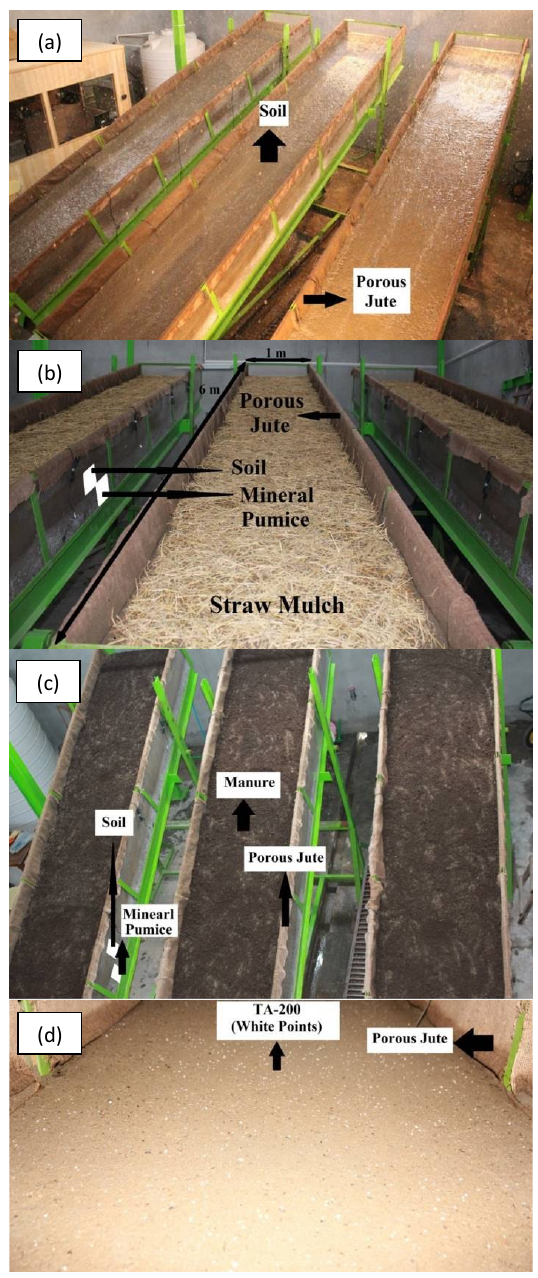
Fig. 1 A view of untreated plots (a), treated plots with rice straw mulch (b), manure (c) and TA-200 polyacrylamide (d) under the lab condition Figure 1. A view of untreated plots (a) , treated plots with rice straw mulch (b) , manure (c) and TA-200 polyacrylamide (d) under the lab